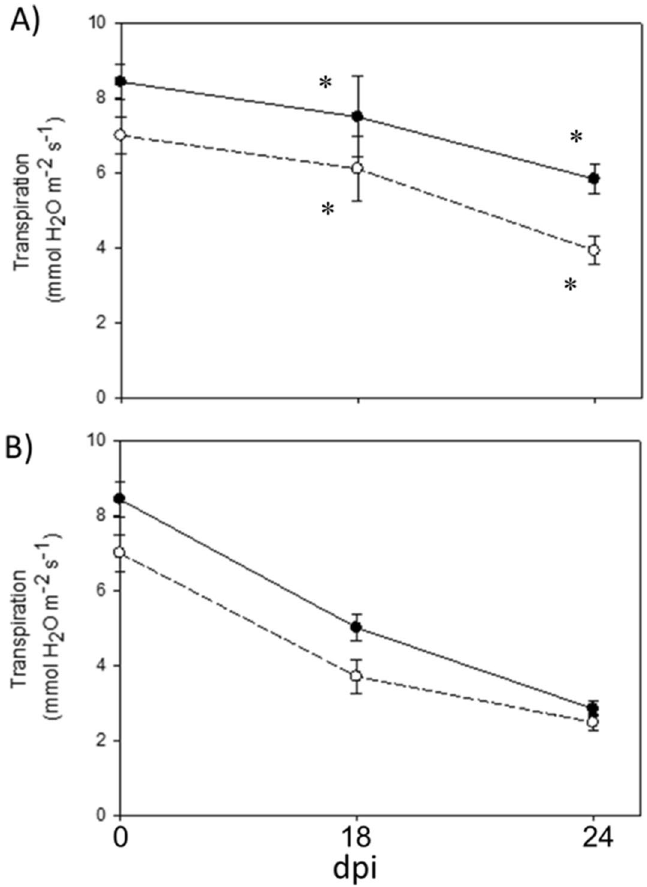
Figure 4. Transpiration rates of control ( A ) and salt stressed ( B ) A. donax plants measured at different sampling times: 1, 18 and 24 dpi (see Fig. 3). Black circles indicate measurements collected from the 2nd leaf (apical leaf) and white circles indicate measurements collected form the 5th leaf form the top (basal leaf). Values are means ± standard errors (n = 4). Shapiro–Wilk test was applied to confirm normal distribution of data. Statistically significant differences between means of either apical or basal leaves of control- and salt-stressed plants are indicated by (*) ( P < 0.05).